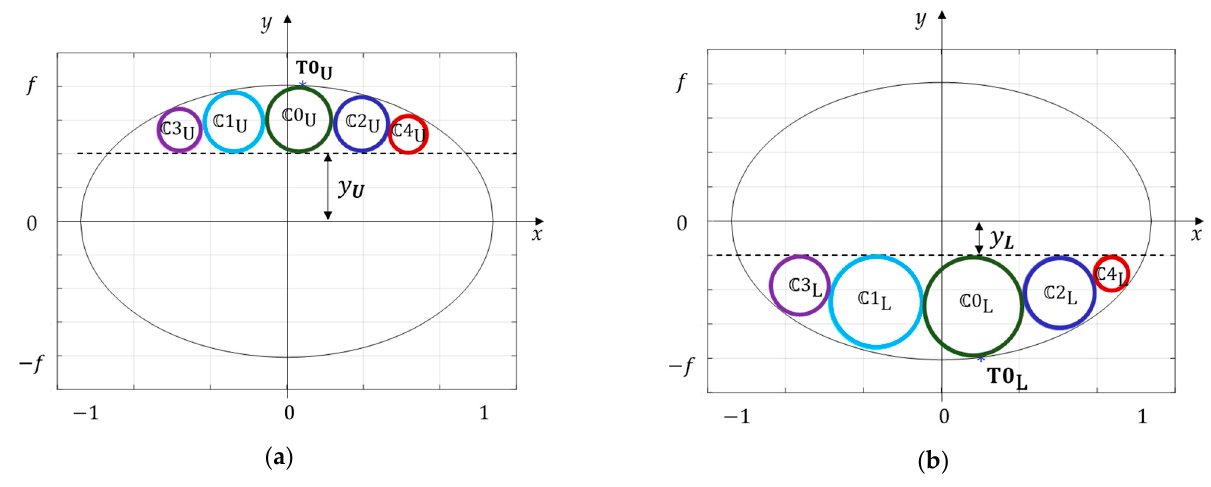
Figure 11. Part-section layouts: ( a ) available space in the upper part of the cross-section; ( b ) available space in the lower part of the cross-section.